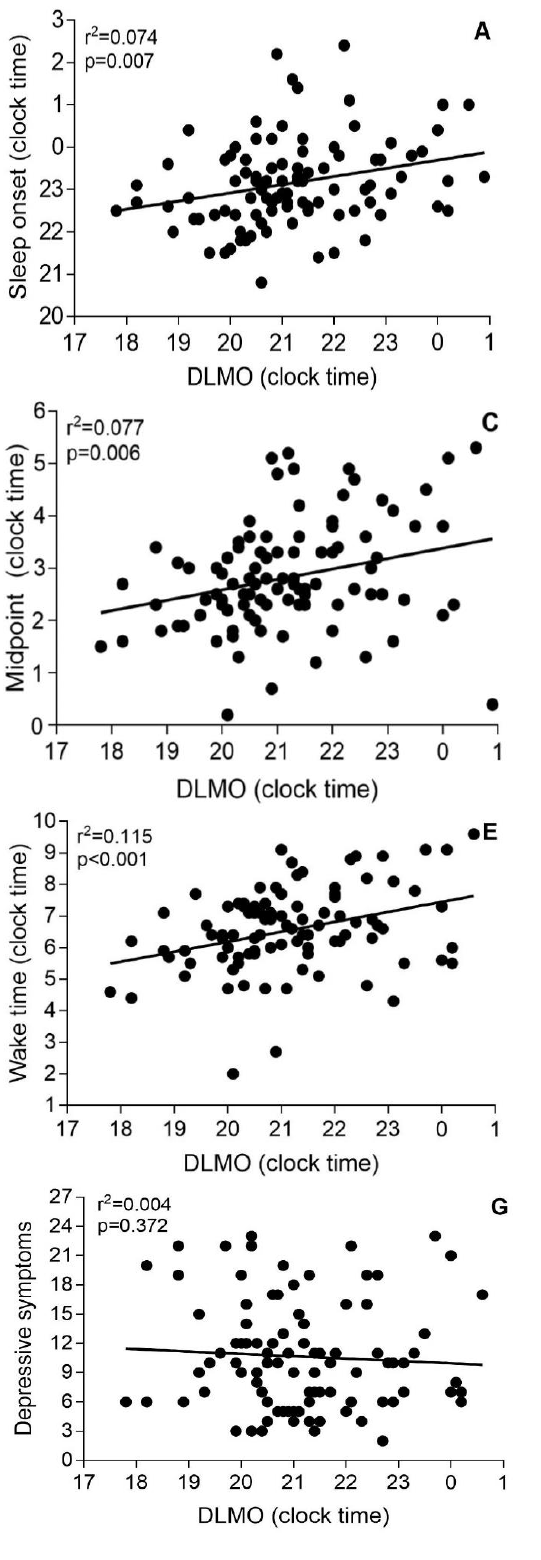
Figure 3. Associations between dim light melatonin onset and sleep-diary-derived sleep onset time ( A ), sleep midpoint ( C ), wake time ( E ), and depressive symptoms ( G ); and associations be- tween chronotype and sleep onset time ( B ), sleep midpoint ( D ), wake time ( F ), and depressive symptoms ( H